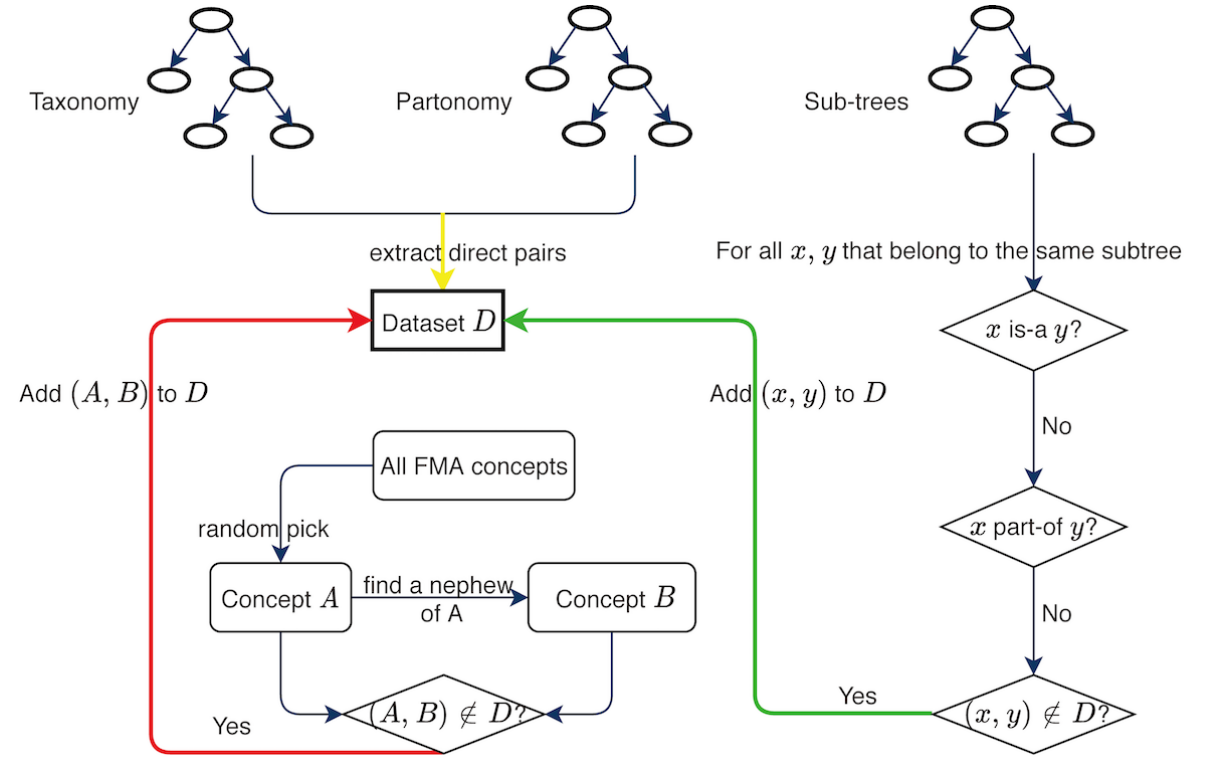
Figure 1. The data preparation process. The final dataset D consists of 3 parts: (1) all of the direct is-a and part-of pairs in the Foundational Model of Anatomy (inputted by the yellow arrow); (2) ndr pairs of terms that share the same ancestor (inputted by the green arrow); and (3) ndr uncle-nephew pairs (inputted by the red